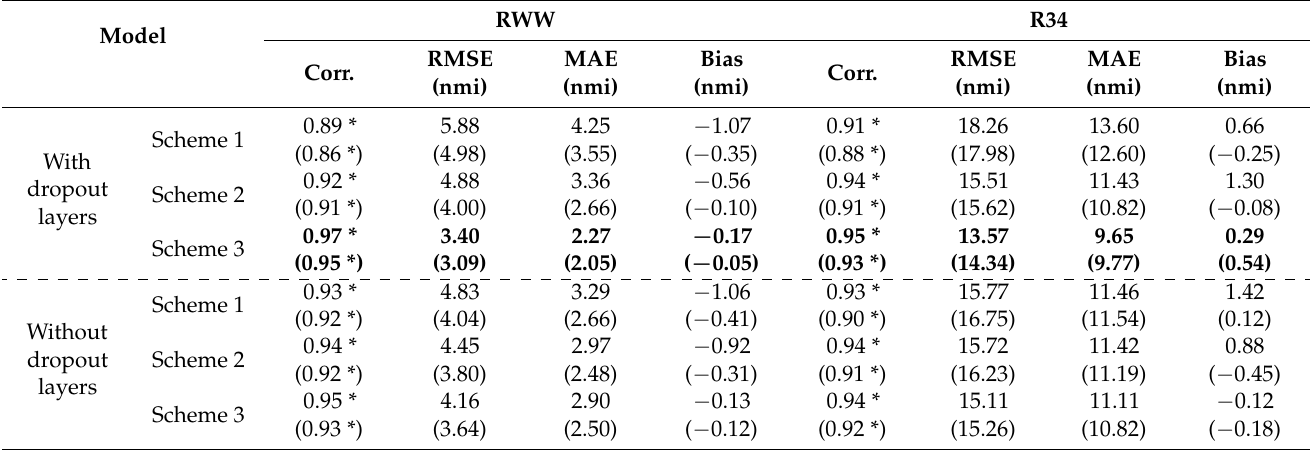
Table 4. Validation and testing results for the three CNN-based TC size estimation models with and without dropout layers. The model with the best validation and testing accuracy is denoted in bold. The asterisks (*) indicate statistical significance at the 99% confidence level based on Student’s t